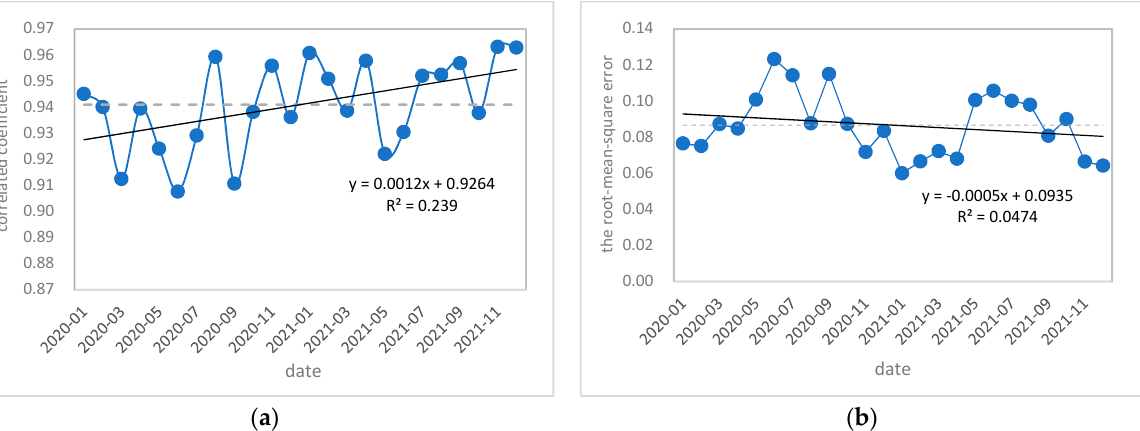
Figure 9. Comparison of the ( a ) coefficient of variation and ( b ) root-mean-square error between FNDVI and MNDVI from January 2020 to December 2021.